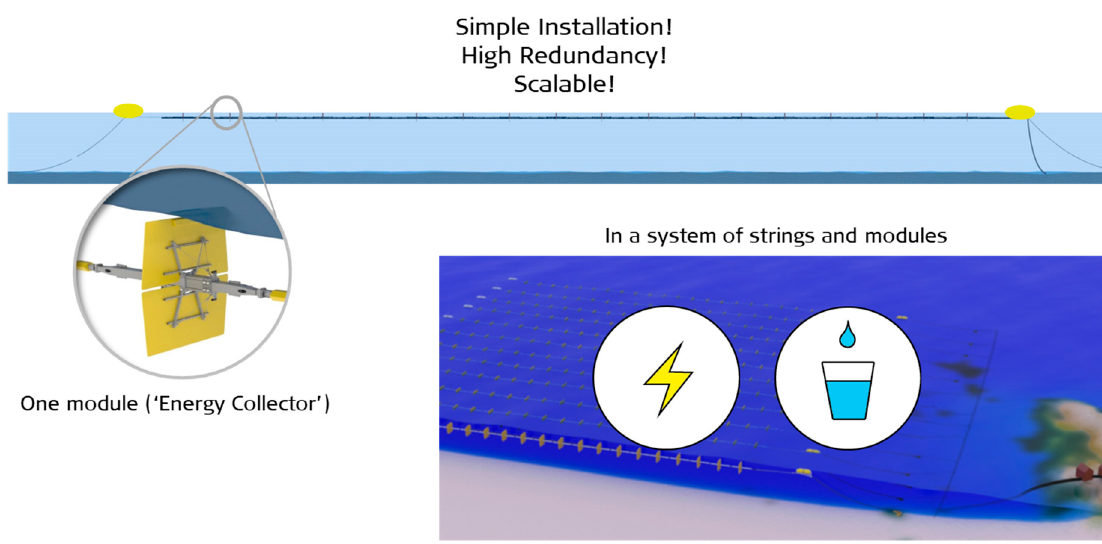
Figure 5. The W2EW